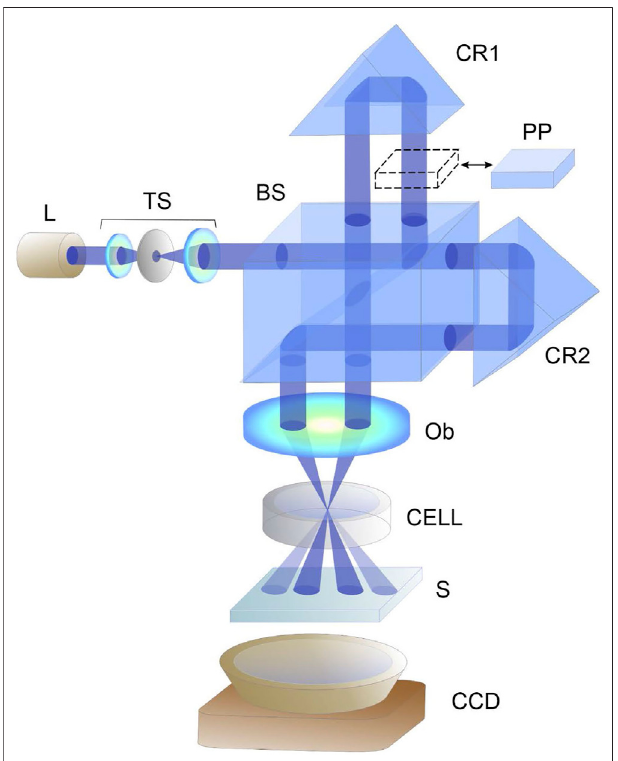
FIGURE7| Opticalarrangementforstudyingtheeffectofself-diffraction in the cell containing the medium with suspended microparticles: (L) CASIX LDS-1500 laser generating at λ = 445 nm and controllable power ≤ 0.3 W; BS, beam splitter; S R1, S R2, 90 ° angle re fl ectors; Ob, micro-objective; S, screen; SS D, registering